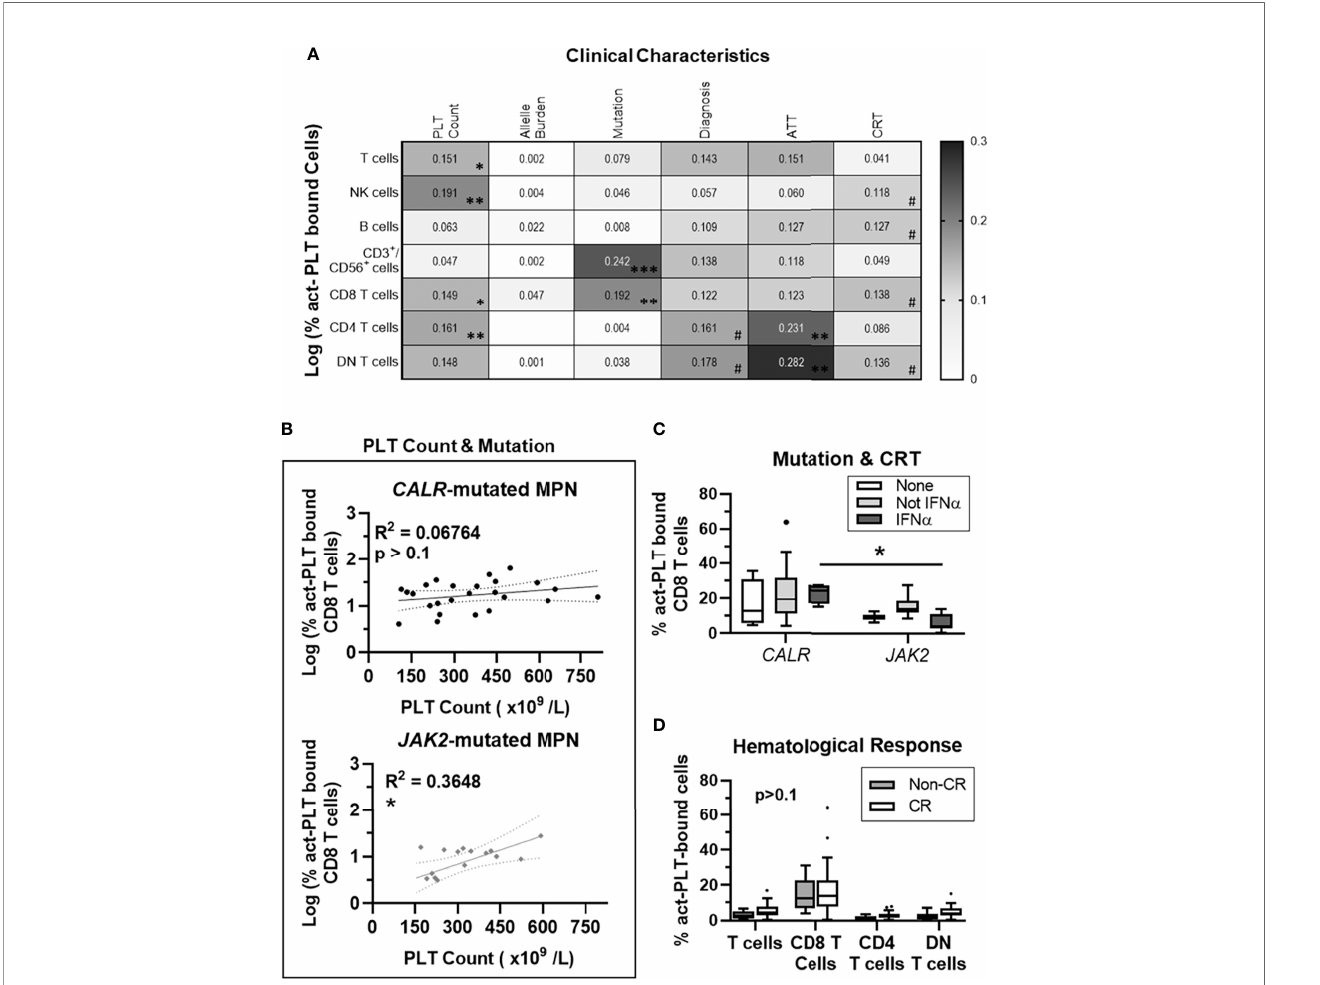
FIGURE 2 | PLT Count correlates with act-PLT-binding to CD8 T cells in JAK2 - but not CALR -mutated MPN patients. 41 MPN patients harboring either CALR or JAK2 mutations were used for regression analysis. (A) The correlation between clinical characteristic (column factors) and the frequencies of activated-PLT (act-PLT) bound cells was analyzed, using single linear regressions. The goodness of fi t (R 2 value) for each linear regression model is shown as a heatmap (0 < R 2 <0.3). The models were considered relevant when R 2 > 0.10 and p-value < 0.05; (B) The correlation between PLT count and the frequency of act-PLT bound CD8 T cells was analyzed independently for CALR - and JAK2 - mutated patients. Dotted lines represent the 95% con fi dence bands of the best- fi t line. The frequencies of act-PLT-bound CD8 T cells were assessed after stratifying the patient population by (C) mutation ( CALR : n = 25; JAK2 : n = 16) and cytoreductive therapy (CRT) therapy. Patients either did not receive any CRT therapy (None, empty bars, n = 6), received IFN a therapy (IFN a , light-grey bars, n = 15), or received CRT other than IFN a (Not IFN a , dark-grey bars, n = 20). (D) Patients were strati fi ed by hematological response – non-complete response (Non-CR; blue bars; n = 12) and complete response (CR; empty bars; n = 29). The frequencies of act-PLT bound T cells, CD8 T cells, CD4 T cells and DN T cells were compared within the strati fi ed MPN population. All frequencies are shown as percentage of parent population, and boxplots follow the Tukey method. Kruskal-wallis test or multiple unpaired T test were used to compare the populations with n ≥ 6. Differences between groups were considered signi fi cant when p < 0.05. Asterisks represent *p < 0.05, **p < 0.01, ***p < 0.001, and ****p < 0.0001. # means the p value ranges from 0.05 < p < 0.1. PLT, Platelets; MPN, Chronic Myeloproliferative Neoplasms; AAT, Anti-thrombotic